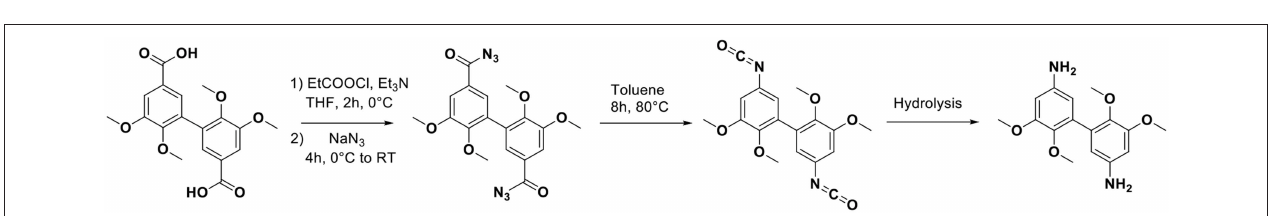
SCHEME 2 | Synthesis of 3,4-dimethoxydianiline (DMAN) from methylated divanillic